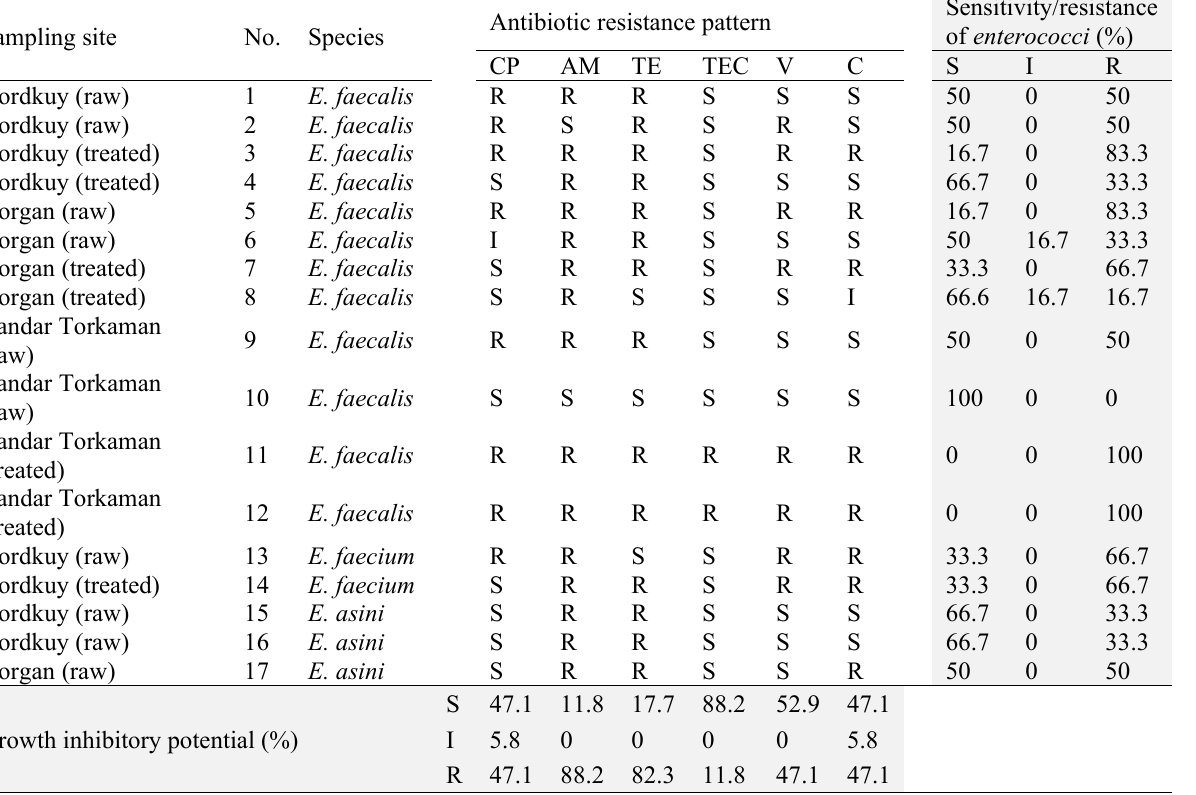
Sensitivity/resistance